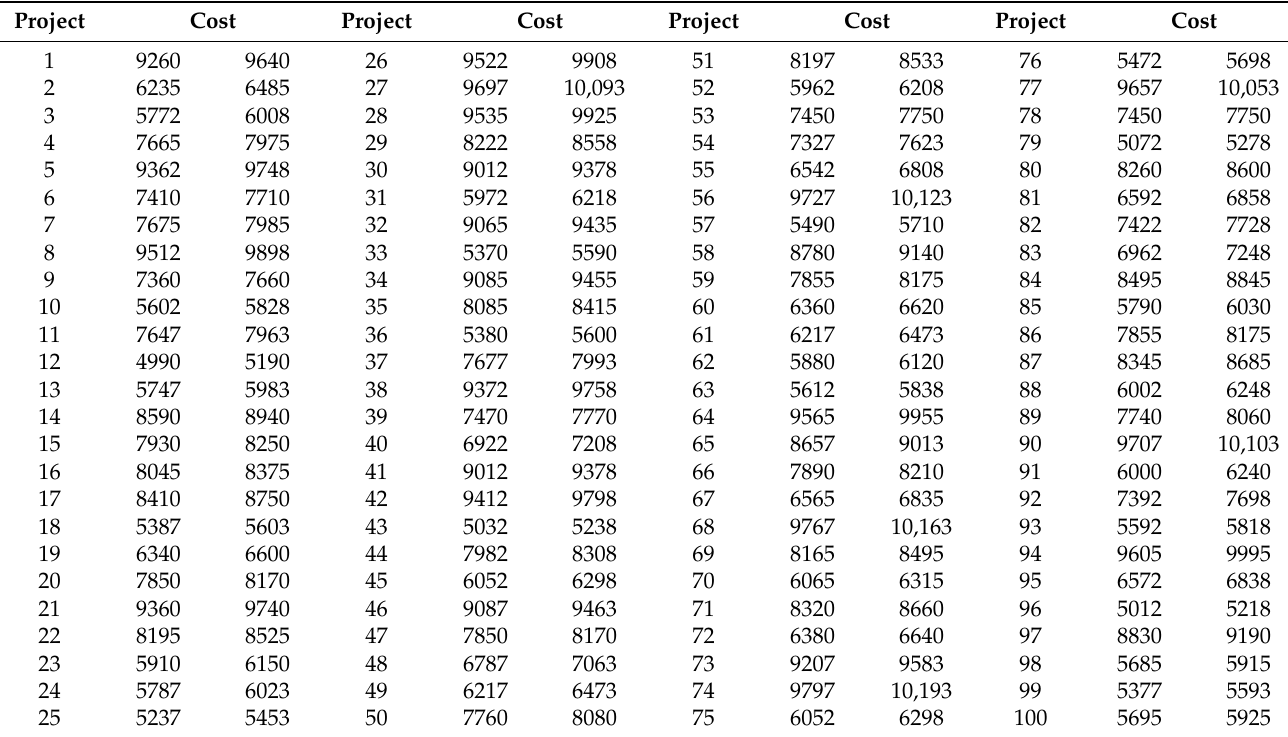
Table A5. Updated budget requirements after the consensus round.